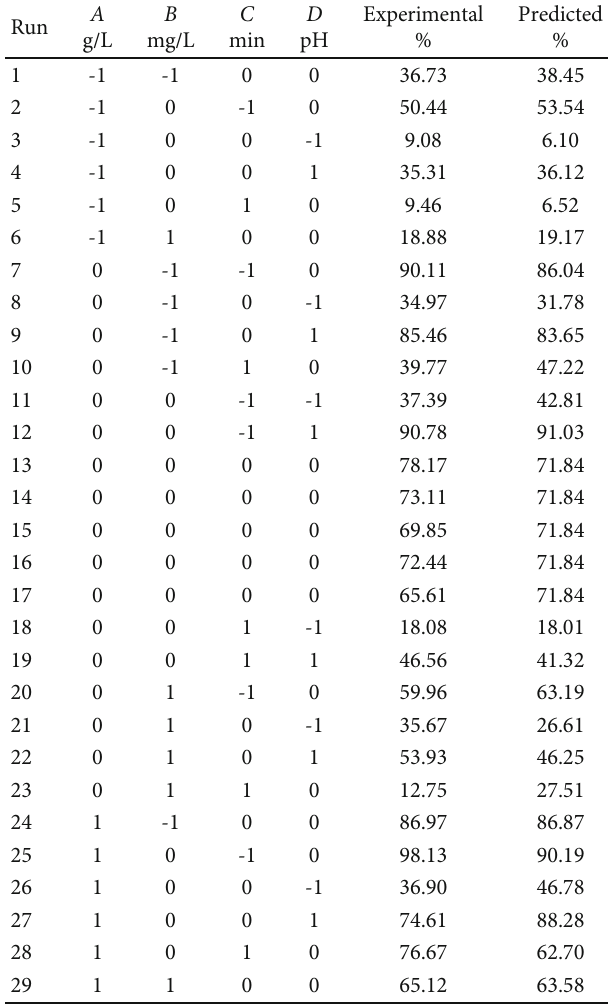
Table 2: Design matrix with experimental results and predicted